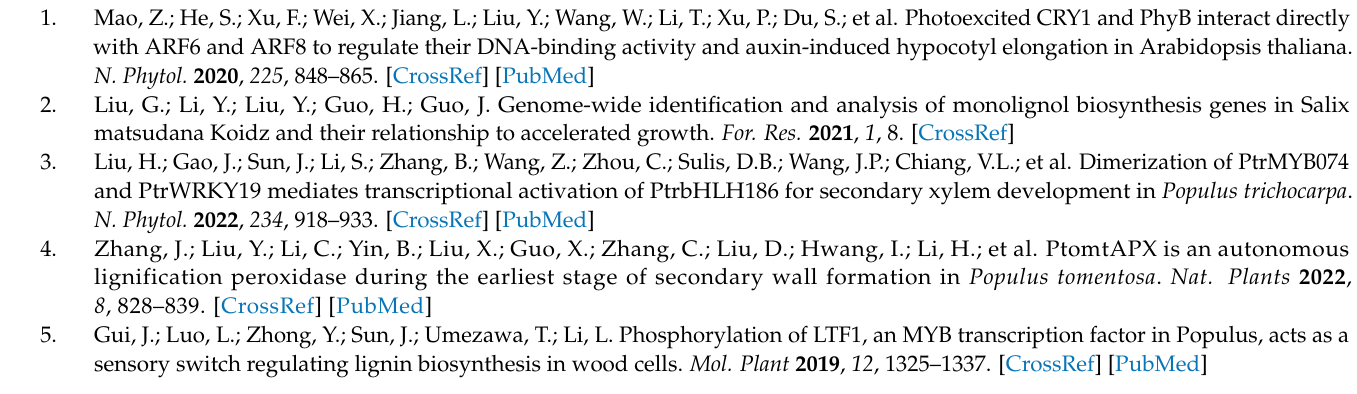
Figure S1: Sequence alignment and corresponding domains of PyuARFs . Figure S2: Number and types of motifs in PyuARFs